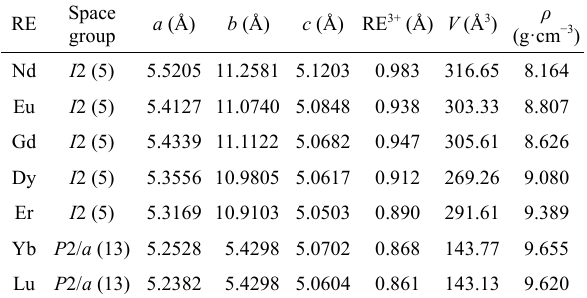
Table 1 Space groups, lattice parameters, cell volumes, and densities of RETaO 4